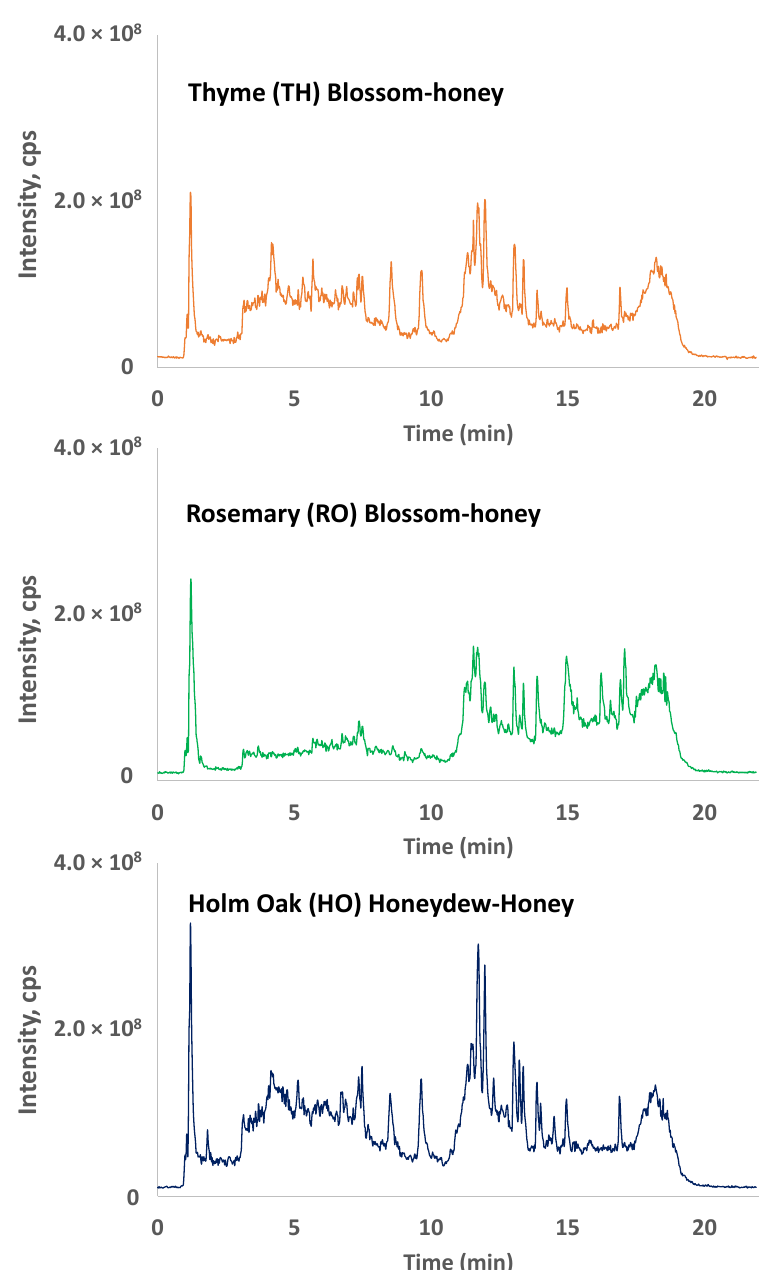
Figure 1. Off-line SPE HPLC-LRMS (total ion chromatogram) polyphenolic fingerprints for three selected honey samples.